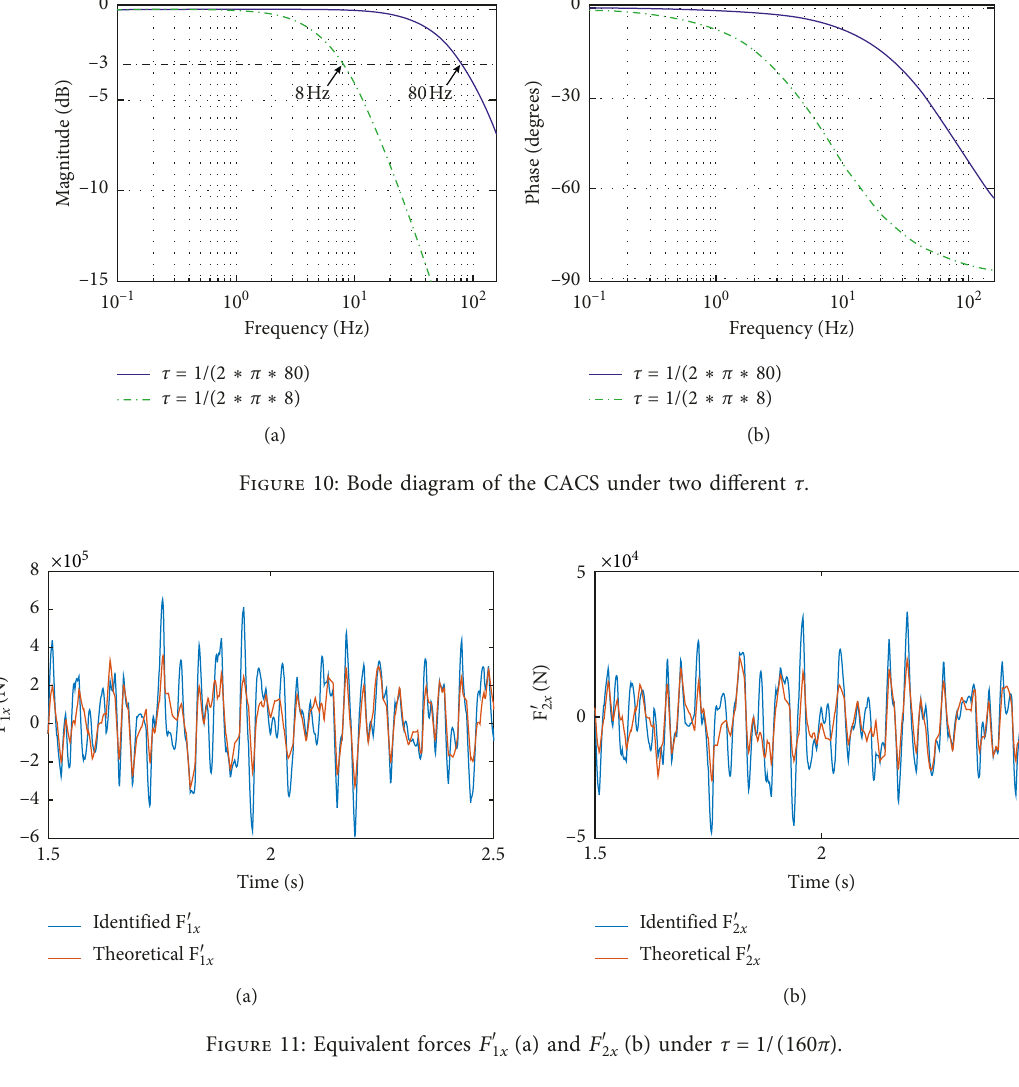
′ (a) and F ′ (b) under τ � 1/ ( 160 π ) 1 x 2 x